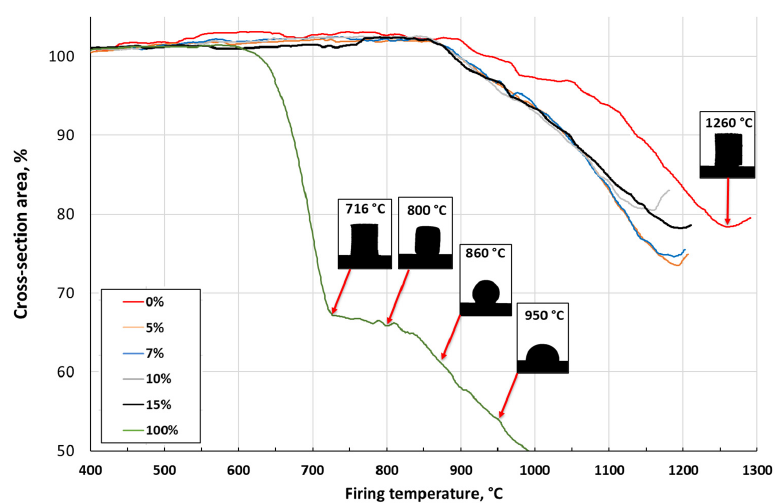
Figure 3. Thermogravimetric (TG) analysis results of the tested clay-glass ceramic materials in temperature range from 20 up to 1050 °C. Detected events (1, 2, and 3) are indicated. The content of glass in wt% is in the legend.